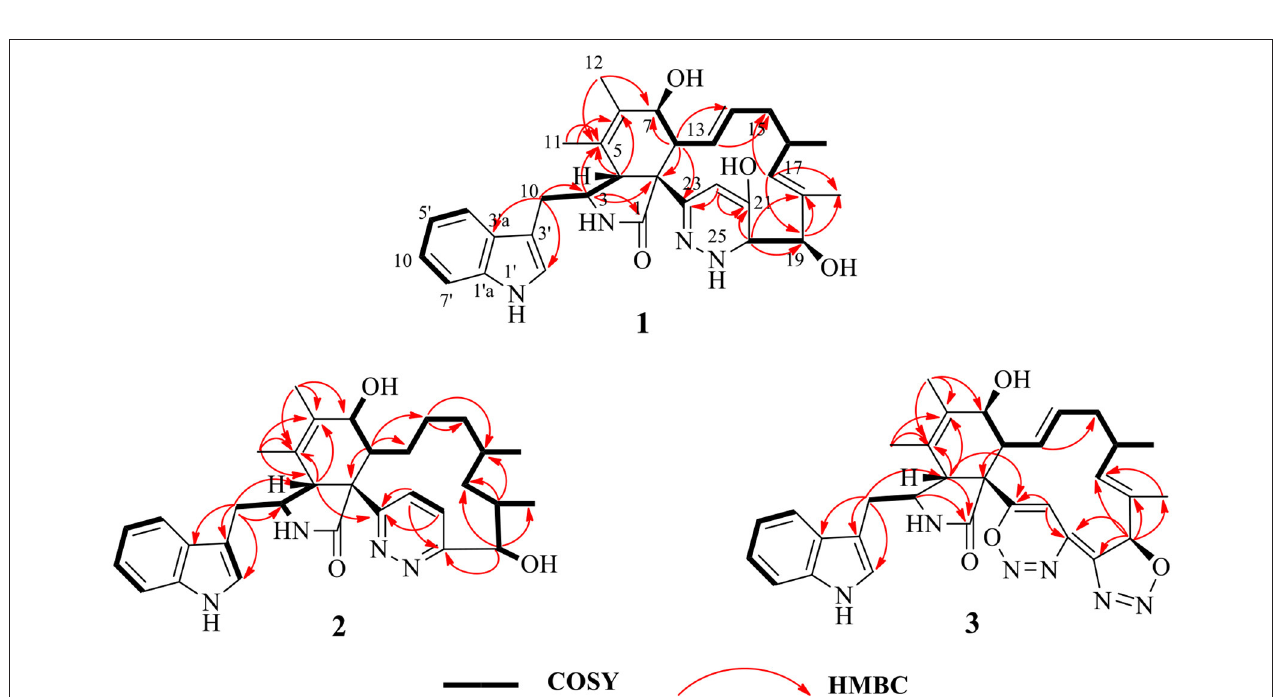
FIGURE 2 | 1 H– 1 H COZY, selected HMBC correlations of compounds 1 – 3 .